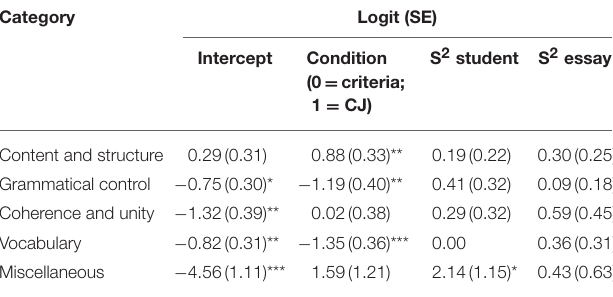
TABLE 4 | Estimates of Logistic Cross-Classified Multilevel Models for Negative Feedback by Category. Category Logit (SE) S 2 student S 2 essay Intercept Condition (0 = criteria; 1 = CJ) Content and structure